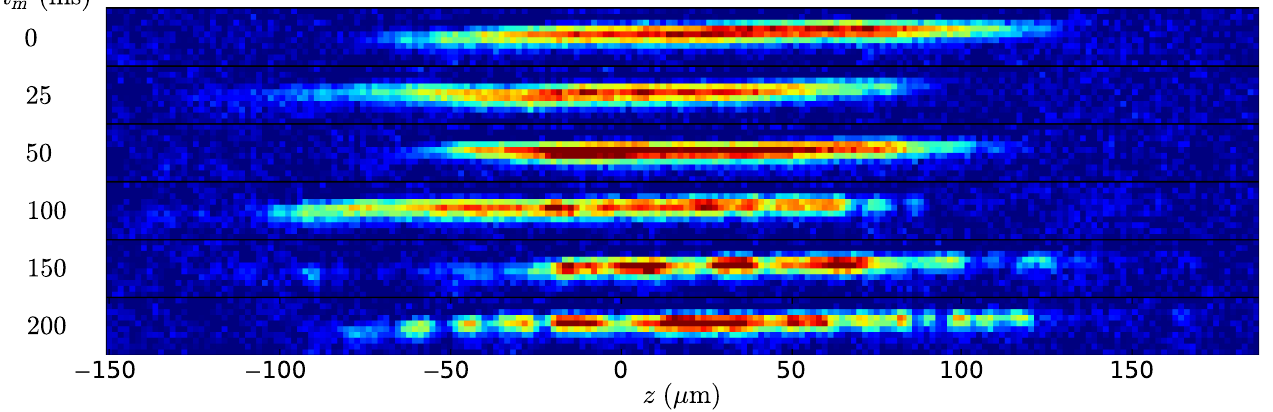
FIG. 11. Experimental column densities showing the formation of grains. Representative column-density images taken at different t ¼ 250 ms. All other parameters are given in the caption of Fig. 7. Each image is a different For each value of t , ω ¼ ð 2 π Þ 70 Hz and t m h realization of the